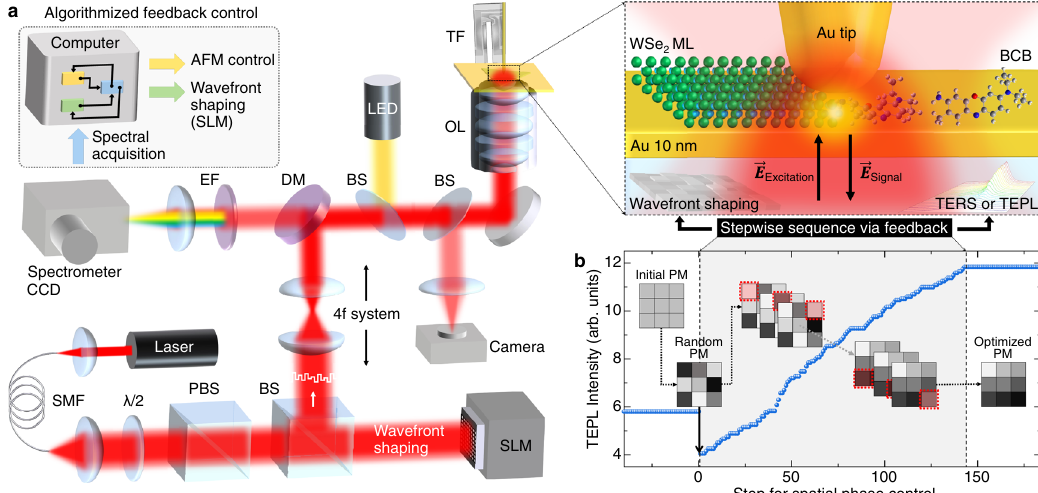
Fig. 1 Adaptive nano-scope for vector- fi eld controlled tip-enhanced nano-spectroscopy based on dynamic wavefront shaping. a Schematic diagram of the experimental setup. For wavefront shaping, a He-Ne laser ( λ = 632.8 nm) is spatially fi ltered and expanded to over fi ll the active area of spatial light modulator (SLM). The wavefront-shaped beam is imaged onto the back aperture of an objective lens (OL) in a 4f system for dynamical manipulation of the tip-LSP. Abbreviations: single-mode fi ber (SMF), half-wave plate ( λ /2), polarizing beam splitter (PBS), beam splitter (BS), dichroic mirror (DM), tuning fork (TF), and edge fi lter (EF). b Evolution of TEPL intensity of a WSe 2 monolayer during the optimization of spatial phase mask (PM) by a stepwise sequential algorithm. With the optimized PM, >2 × stronger TEPL response is obtained compared to conventional TEPL set-up. PMs in ( b ) are illustrations (see Supplementary Fig. 2 for real PMs we